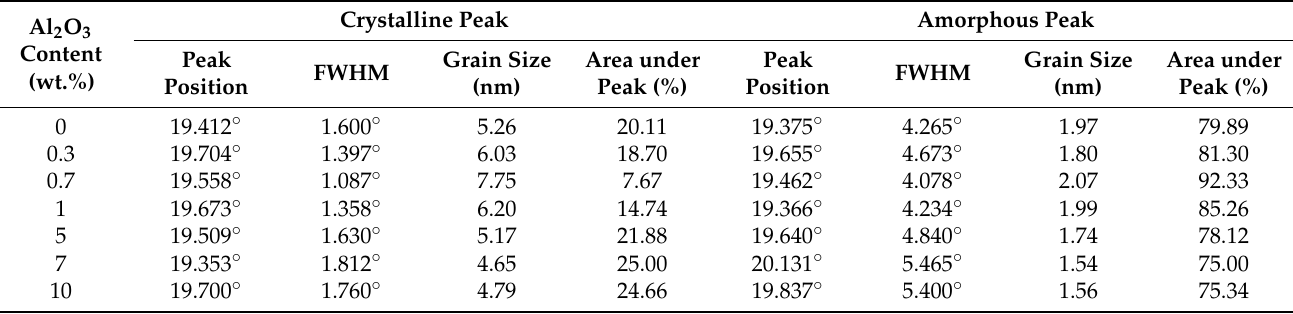
Table 1. The peak position, FWHM, grain size, and area under the peak for the crystalline and amorphous peaks for PVA/10 wt.% PEG/20 wt.% SSA membranes with different concentrations of Al 2 O 3